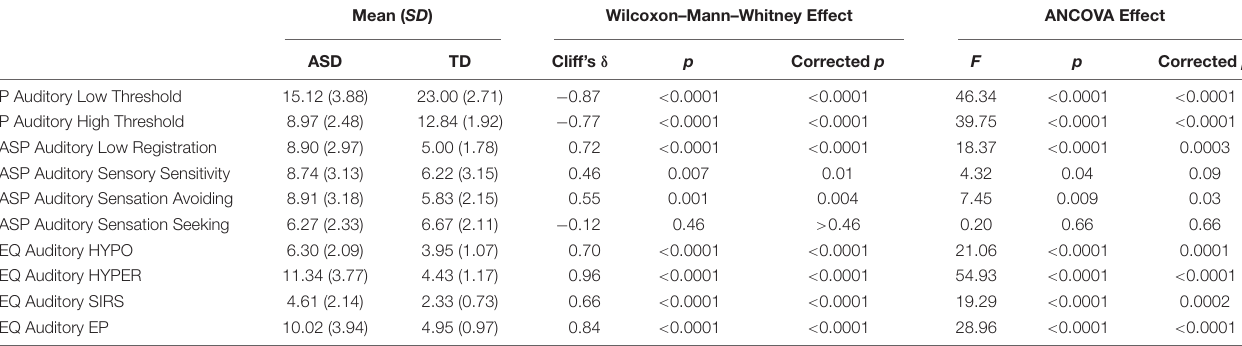
FIGURE 2 | (A) Splined scalp topographies over the left and right hemispheres in the time window of the auditory Tb response (135–195 ms). Electrodes used to the measure the Tb response are highlighted in magenta. Note that electrode positions are based on observations from a Polhemus digitizer and may appear slightly irregular as a result. (B) Splined scalp topographies over the left (contralateral) hemisphere in the time window of the somatosensory P60 response (38 – 78 ms). Electrodes used to the measure the P60 response are highlighted in blue. TABLE 3 | Results of statistical comparisons of autistic and typically developing groups on Sensory Profile (SP), Adolescent-Adult Sensory Profile (AASP), and Sensory Experiences Questionnaire (SEQ) scores in the auditory modality. Mean ( SD